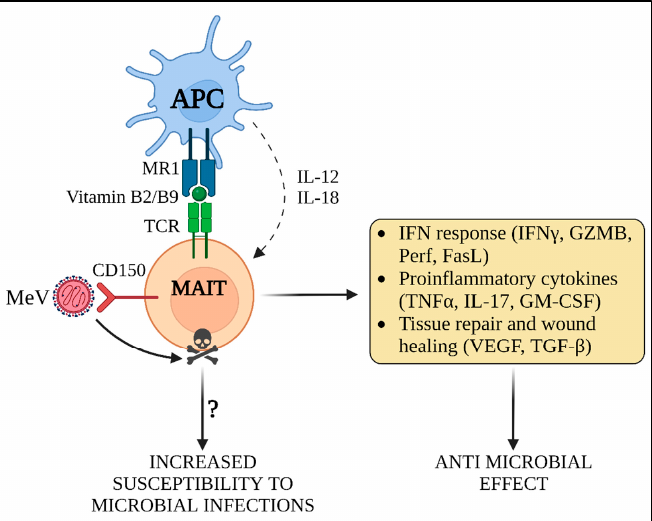
Figure 4. MeV-induced innate immune amnesia. MAIT cells recognize vitamin B2 and B9 metabo- lites presented in MR1 by antigen presenting cells (APC). In addition, they can be activated inde- pendently of MHC antigen presentation through the expression of IL-12 and IL-18 by APCs, which is the predominant mode of activation occurring in viral infections. MAIT cells contribute to the induction of IFN response and cytokine expression, exerting a direct and non-specific an- ti-microbial activity against invading pathogens. Moreover, they perform additional functions, such as tissue remodeling and wound healing. MeV rapidly infects MAIT and triggers their death by apoptosis. Due to the elimination of MAIT cells, the innate response against both MeV and secondary microbial infections may be suppressed, thus inducing a transient state of “innate im- mune amnesia”. GZMB: granzyme B; Perf: perforin; FasL: Fas ligand; TNF α : tumor necrosis factor alpha; IL-17: interleukin 17; GM-CSF: granulocyte-macrophage colony stimulatory factor; VEGF: vascular endothelial growth factor; TGF- β : transforming growth factor beta.